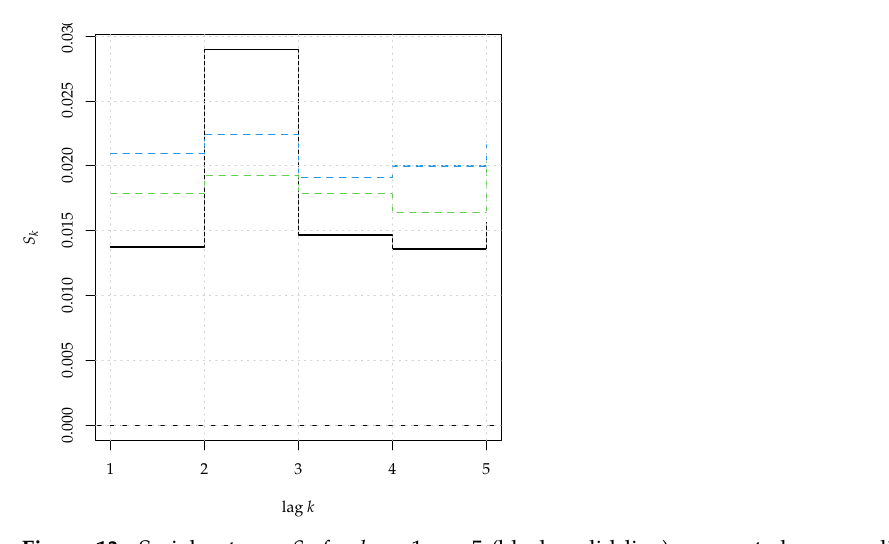
Figure 13. Serial entropy S k for k = 1, . . . ,5 (black, solid line), computed on a realization of a nonlinear MA(1) process. The rejection bands at 95% (green dashed line) and 99% (blue dashed line) correspond to the null hypothesis of a general linear